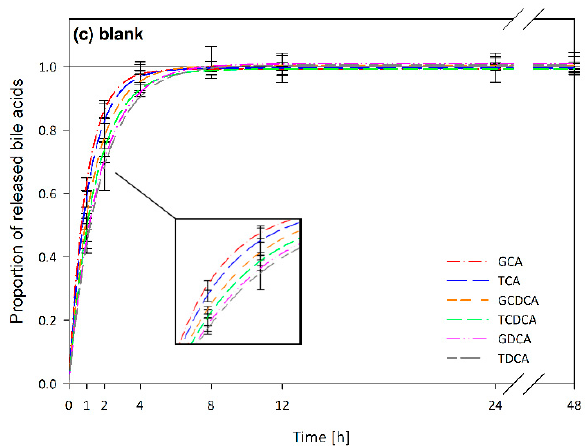
Figure 4. Diffusion kinetics of bile acid release (glycocholic acid (GCA), taurocholic acid (TCA), glycochenodesoxycholic acid (GCDCA), taurochenodesoxycholic acid (TCDCA), glycodesoxycholic acid (GDCA), taurodesoxycholic acid (TDCA)) of in vitro digested ( a ) maize fibre preparation, ( b ) apple fibre preparation and ( c ) blank digestion.